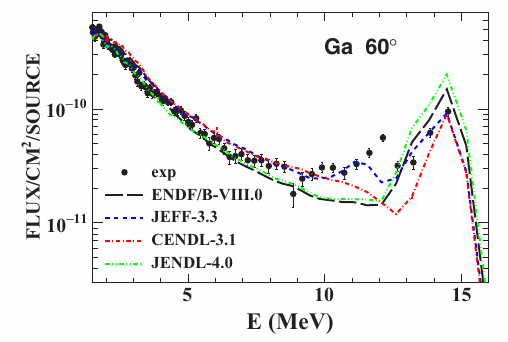
lines are those from the MCNP simulations using the eval- uated databases of ENDF / B-VIII.0 (long-dashed), JEFF- 3.3 (dashed), CENDL3.1 (dashed-dot) and JENDL4.0 (dashed-dot-dot). The errors presented in the figure are from the statistical and systematic errors. The new major release VIII.0 of the ENDF / B and JEFF-3.3 nuclear data libraries have been tested using benchmark calculations.